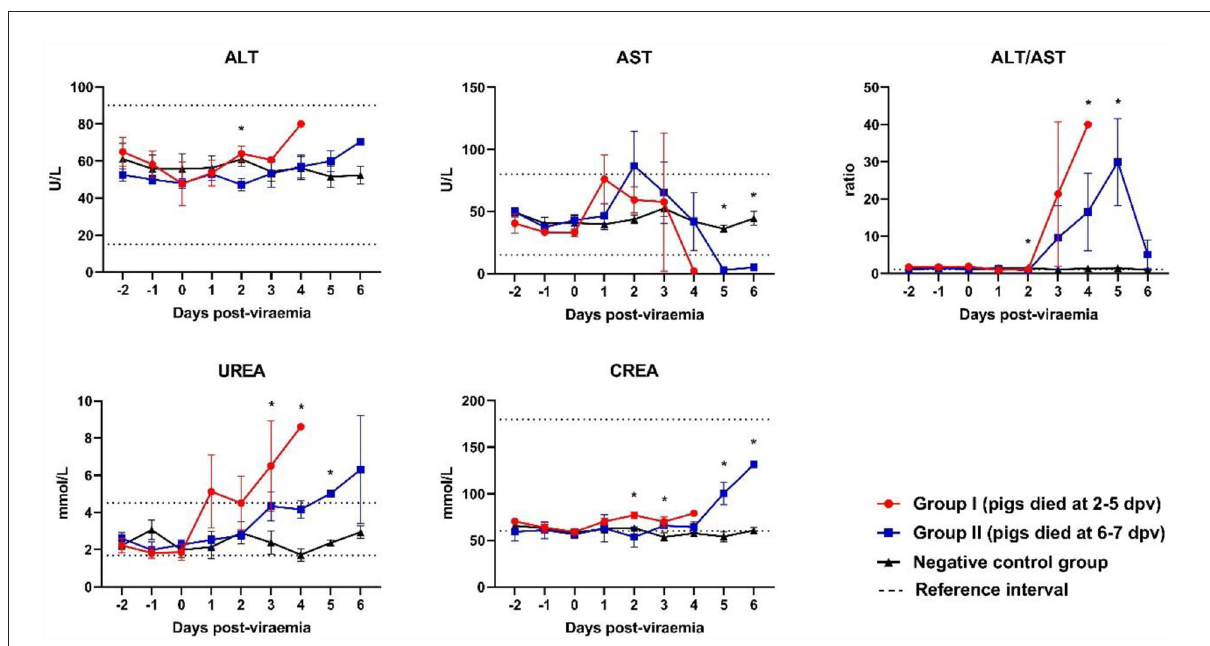
FIGURE4 Biochemical parameters of the liver and kidneys. * p < 0.05. ALT, alanine aminotransferase; AST, aspartate aminotransferase; CREA, creatinine; UREA, urea. The reference intervals of each blood parameter are represented as dotted